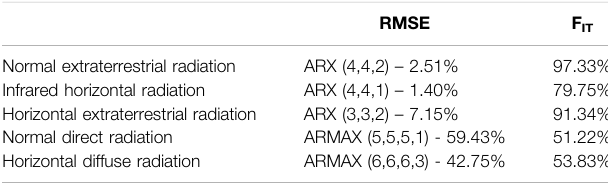
TABLE 7 | RMSE and F IT of the most accurate models for each radiation component generated from horizontal global radiation. Normal extraterrestrial radiation